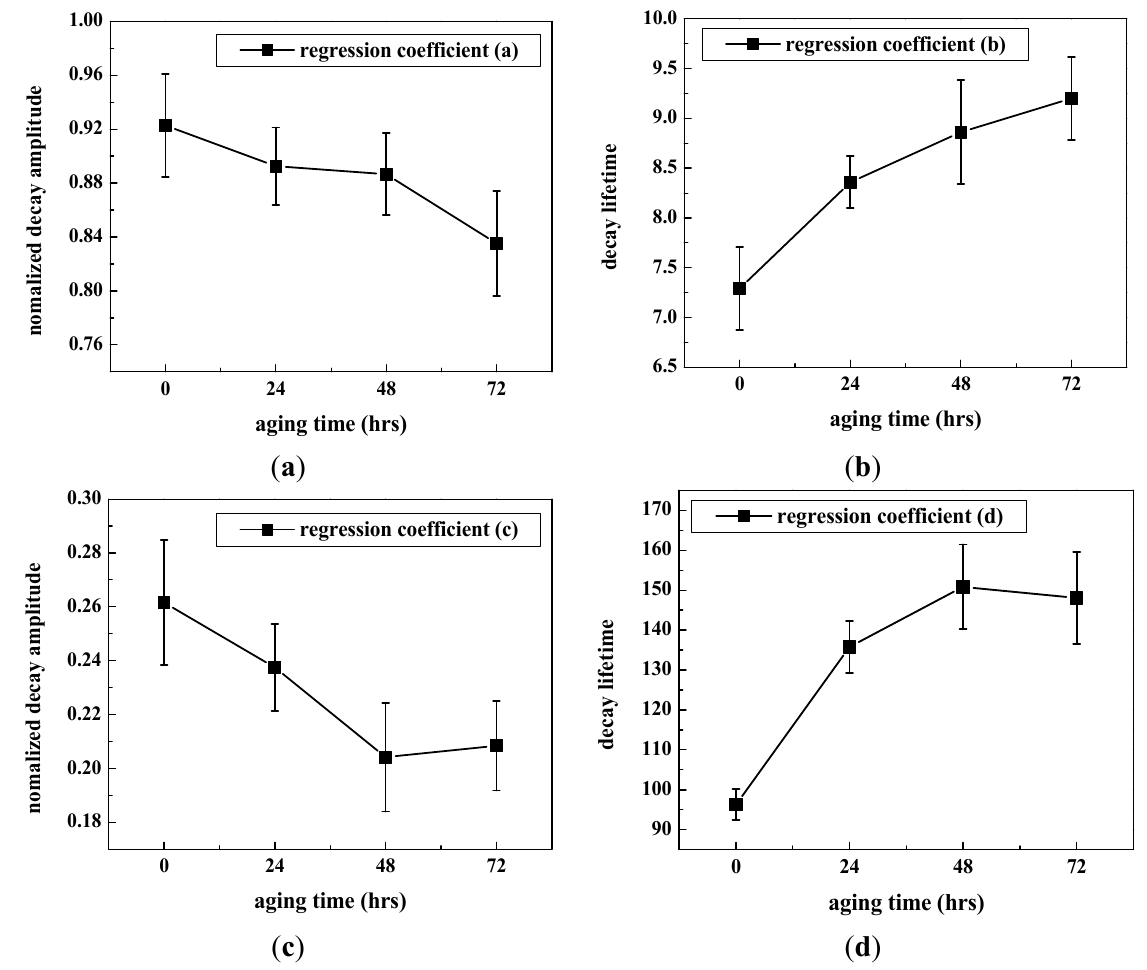
Figure 5. Regression coefficients of thermal decay signals from groups of healthy seeds and seeds aged for 24, 48, or 72 h. Values are represented as mean ± standard